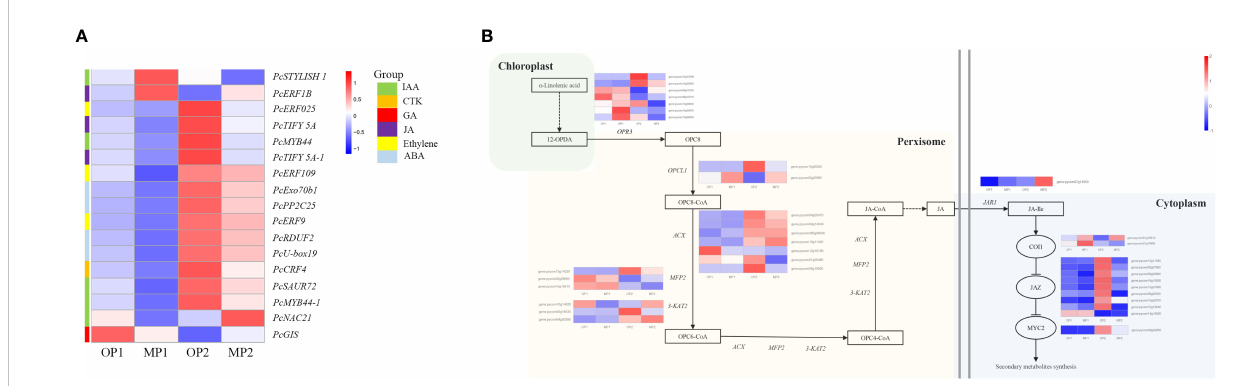
FIGURE 5 Differentially expressed genes involved in plant hormone signaling pathways and in jasmonate biosynthetic and signal transduction pathways. (A) Hormone-related DEGs, in which MP1 and OP1 were the shoot dormancy, MP2 and OP2 were the bud expanding stage. (B) Pathway constructed based on KEGG pathways and the literature. The enzymes and intermediates are indicated as follows: OPR3, OPDA reductase; ACX, acyl-coenzyme A oxidase; MFP2, peroxisomal fatty acid beta-oxidation multifunctional protein; 3-KAT2, 3-ketoacyl-CoA thiolase 2; JAR1, jasmonate resistant 1;